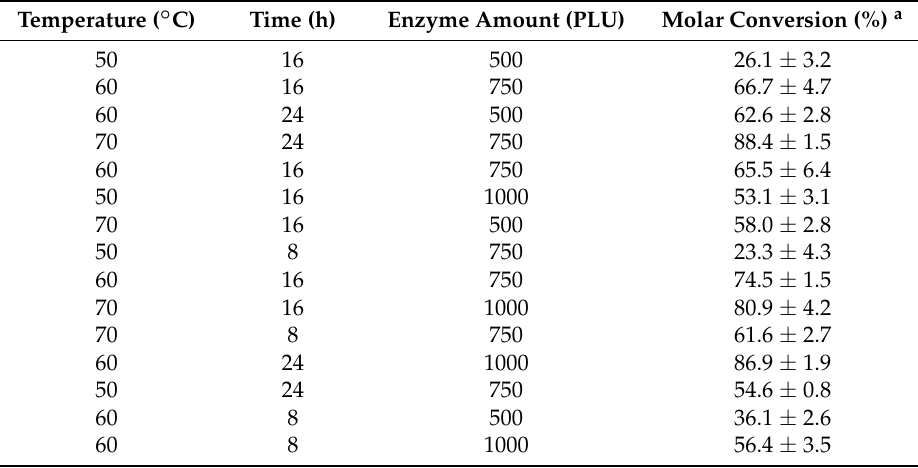
Table 1. The proposed Box–Benhken design (BBD) and experimental data.